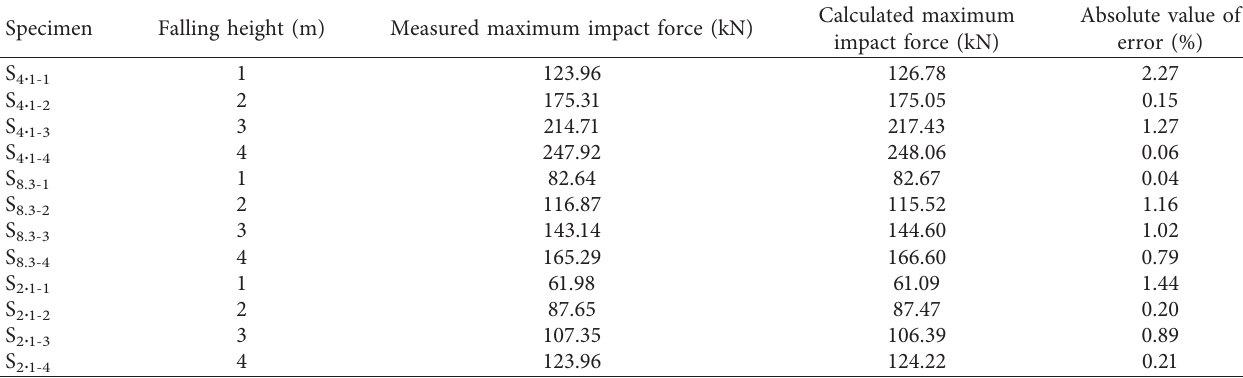
Table 9: Comparison between the calculated values and the measured values of the maximum